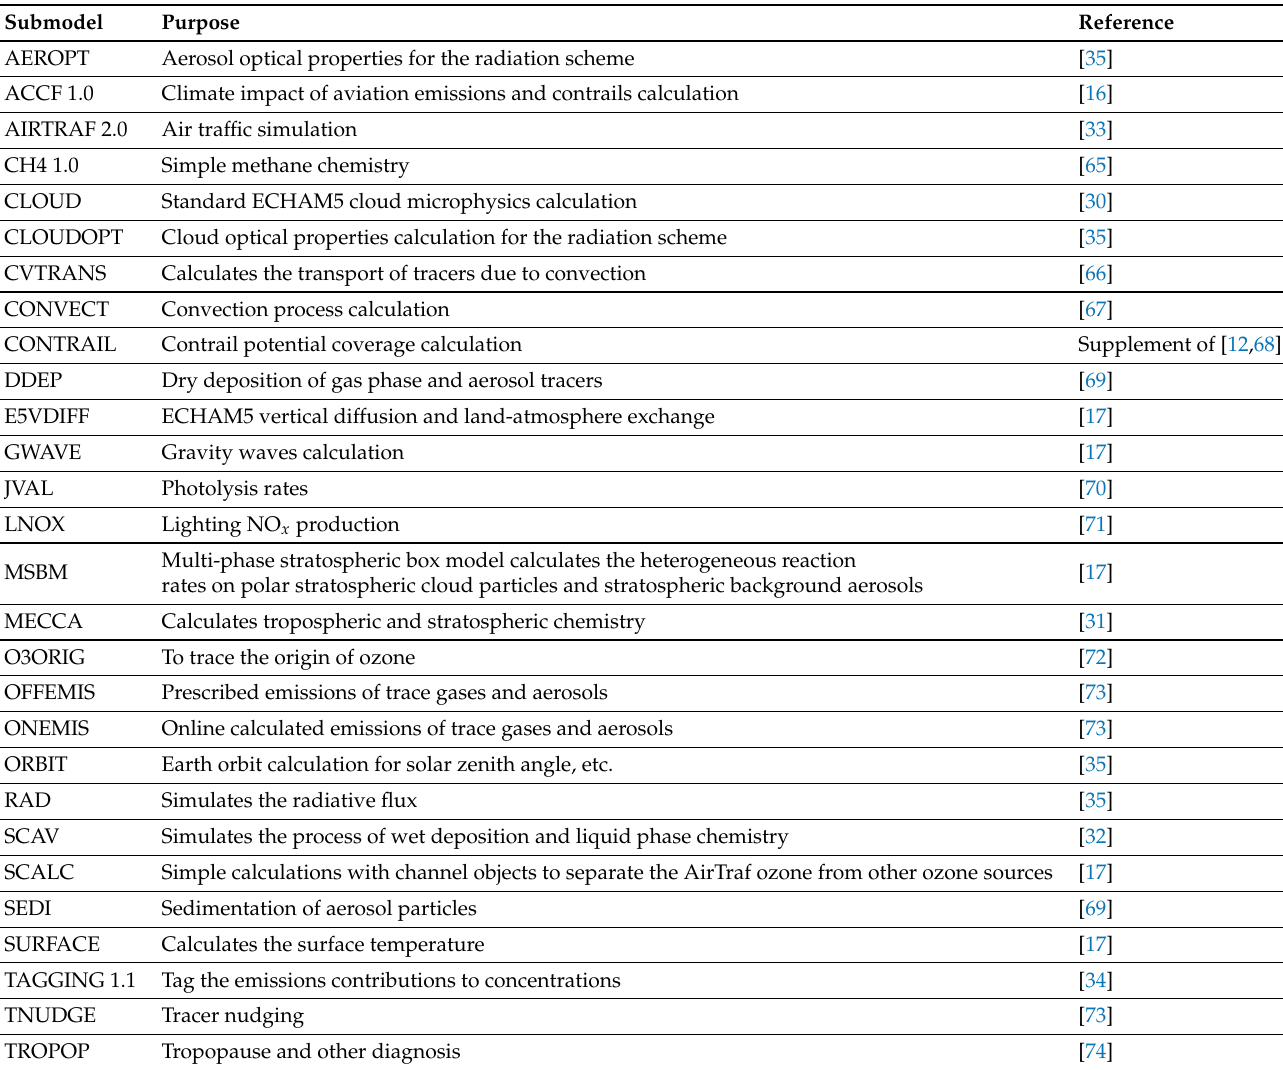
Table A1. List of EMAC submodels used in the